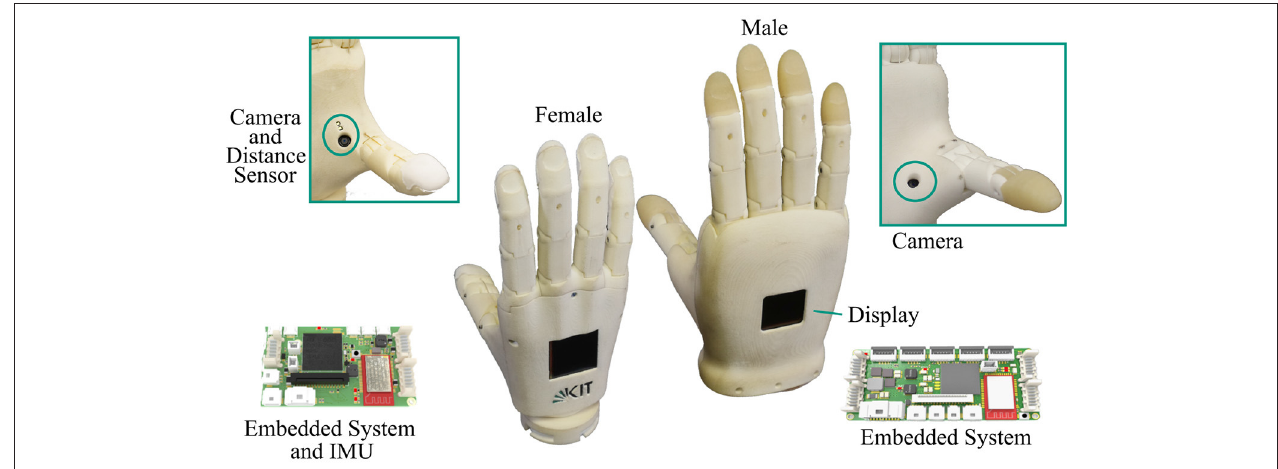
FIGURE 1 | The KIT Prosthetic Hands; female (left) and male (right) intelligent hand prostheses designed for semi-autonomous grasp control. Each hand has two DC motors actuating 10 DoF via an underactuated mechanism. Each hand is equipped with a camera in the palm, IMU and a distance sensors (female version) as well as an integrated embedded system for in-hand sensor data processing and control.